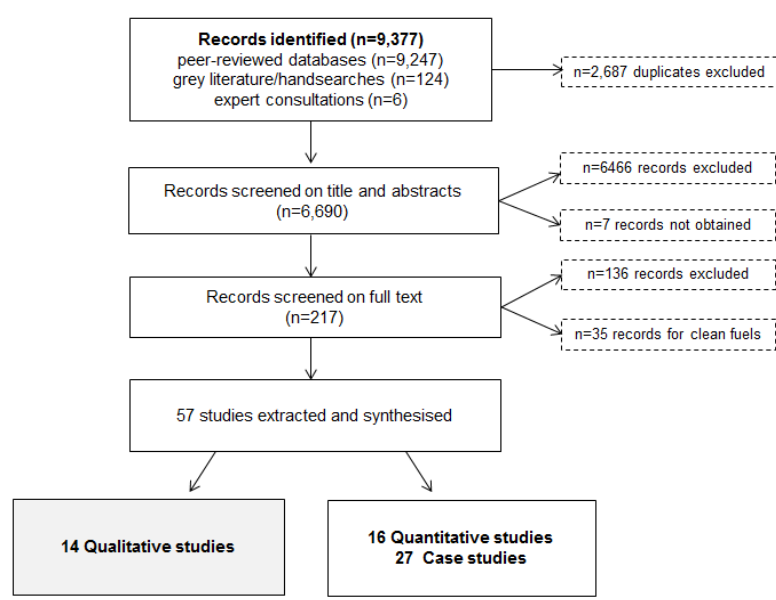
Figure 1. Flowchart of search